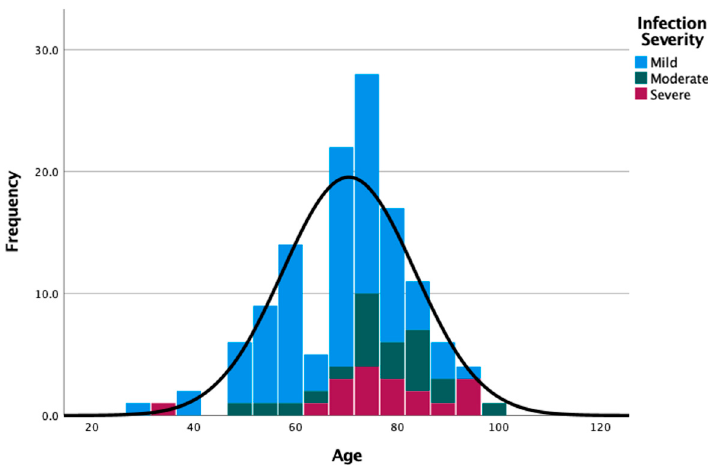
Figure 2. Distribution of patients by age groups and COVID-19 severity.